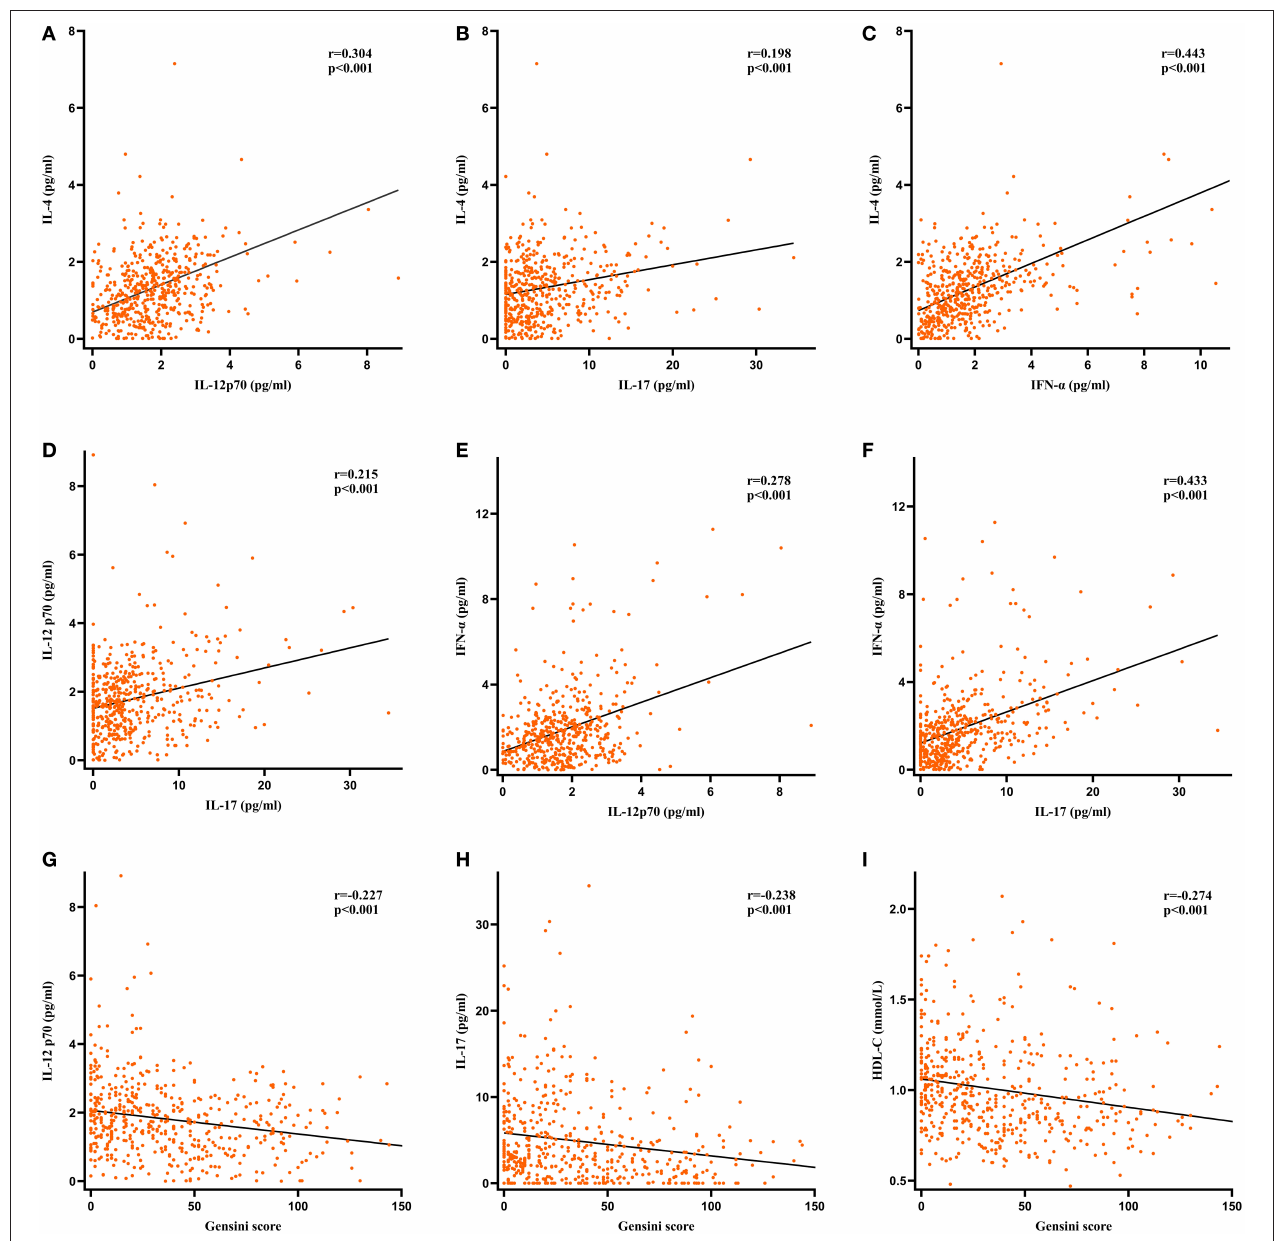
FIGURE 3 | Scatterplots of serum cytokines levels, HDL-C and Gensini score. r, correlation coefficient. (A–F) Correlation among IL-4, IL-12p70, IL-17 and IFN- α . (G–I) The levels of IL-12p70, IL-17 and HDL-C were negatively correlated with Gensini